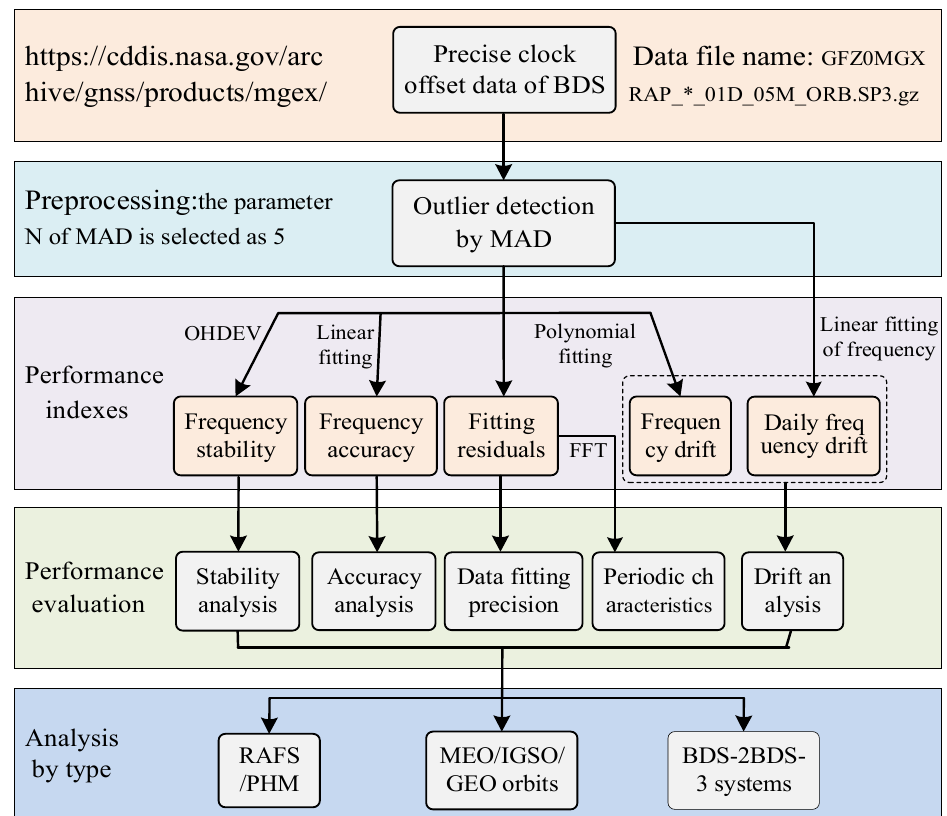
Figure 5. Evaluation process of main indicators.